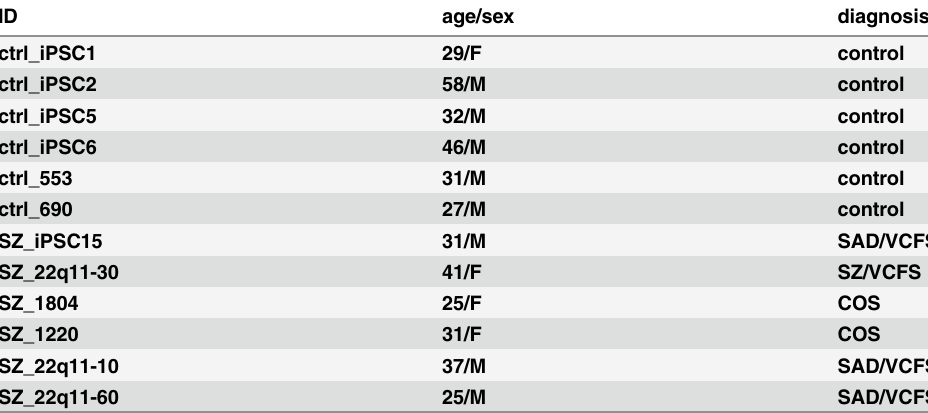
Table 1. Demographics of subjects used for generating iPSCs.